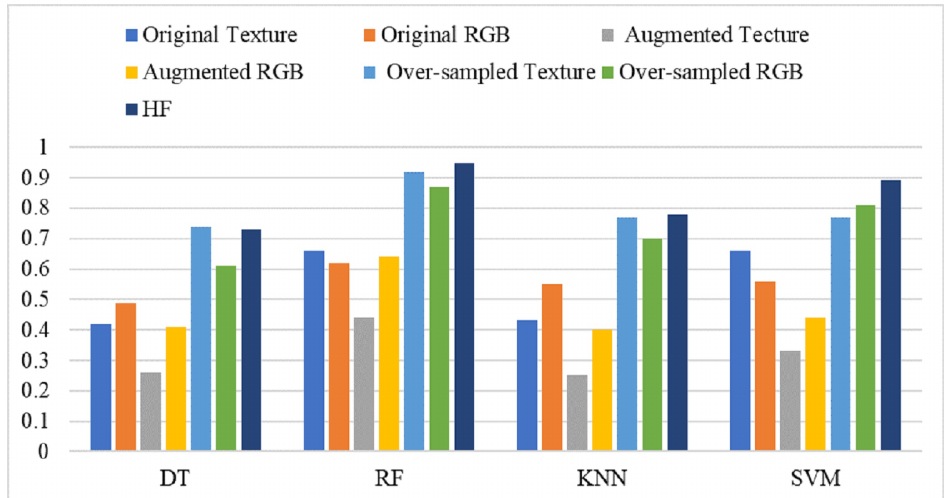
Figure 6. Comparison between all machine learning approaches used for classification of WBC types.